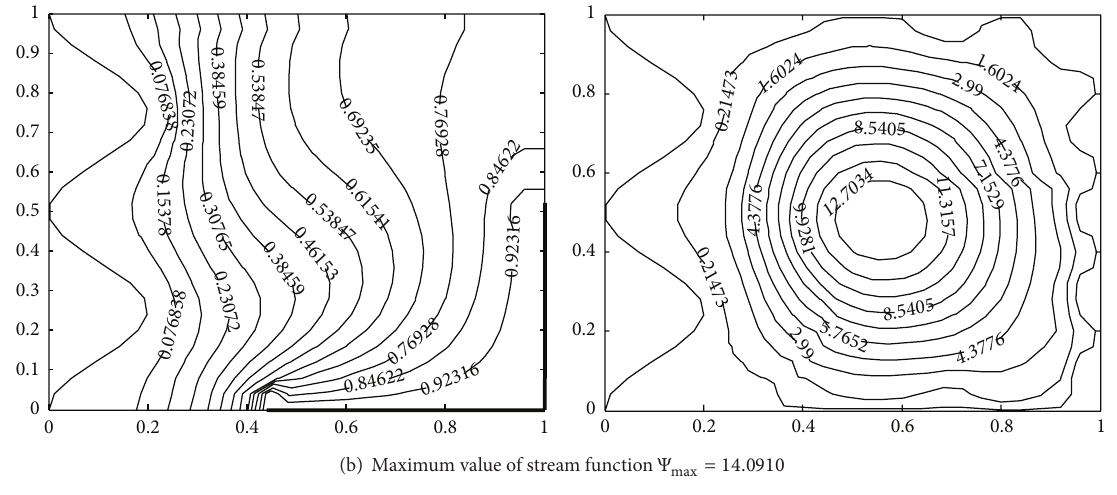
(b) Maximum value of stream function Ψ max = 14.0910